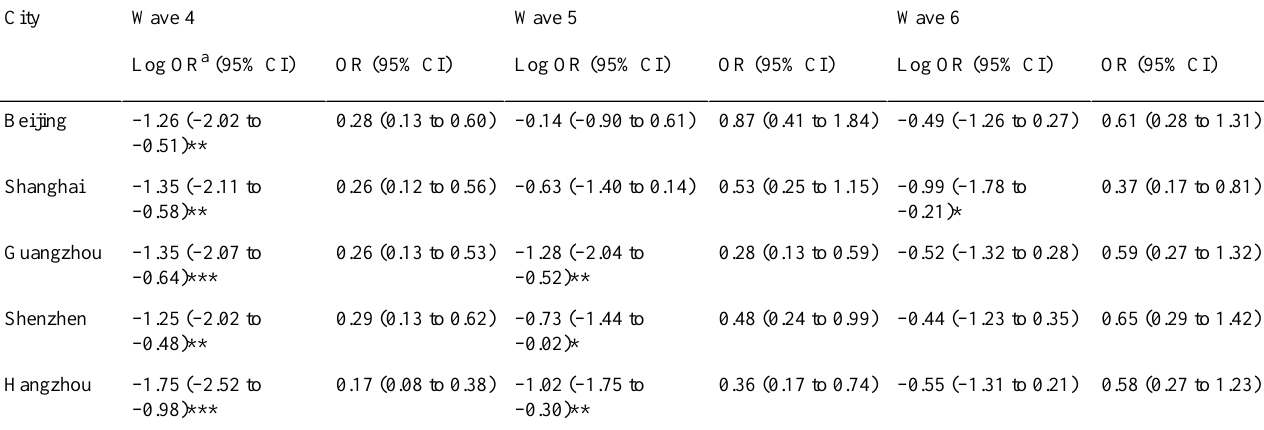
Table 8. City differences in staying at home waves 4, 5, and 6 (Wuhan was used as the reference